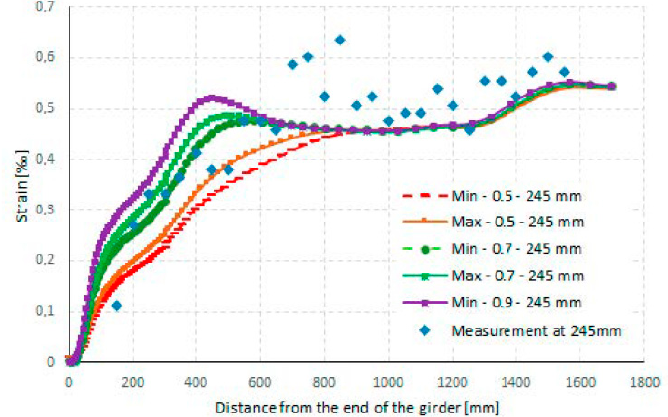
Figure 11. Comparison between FE models and DEMEC mechanical strain gauge measurements at a height of 245 mm from the bottom of the girder.